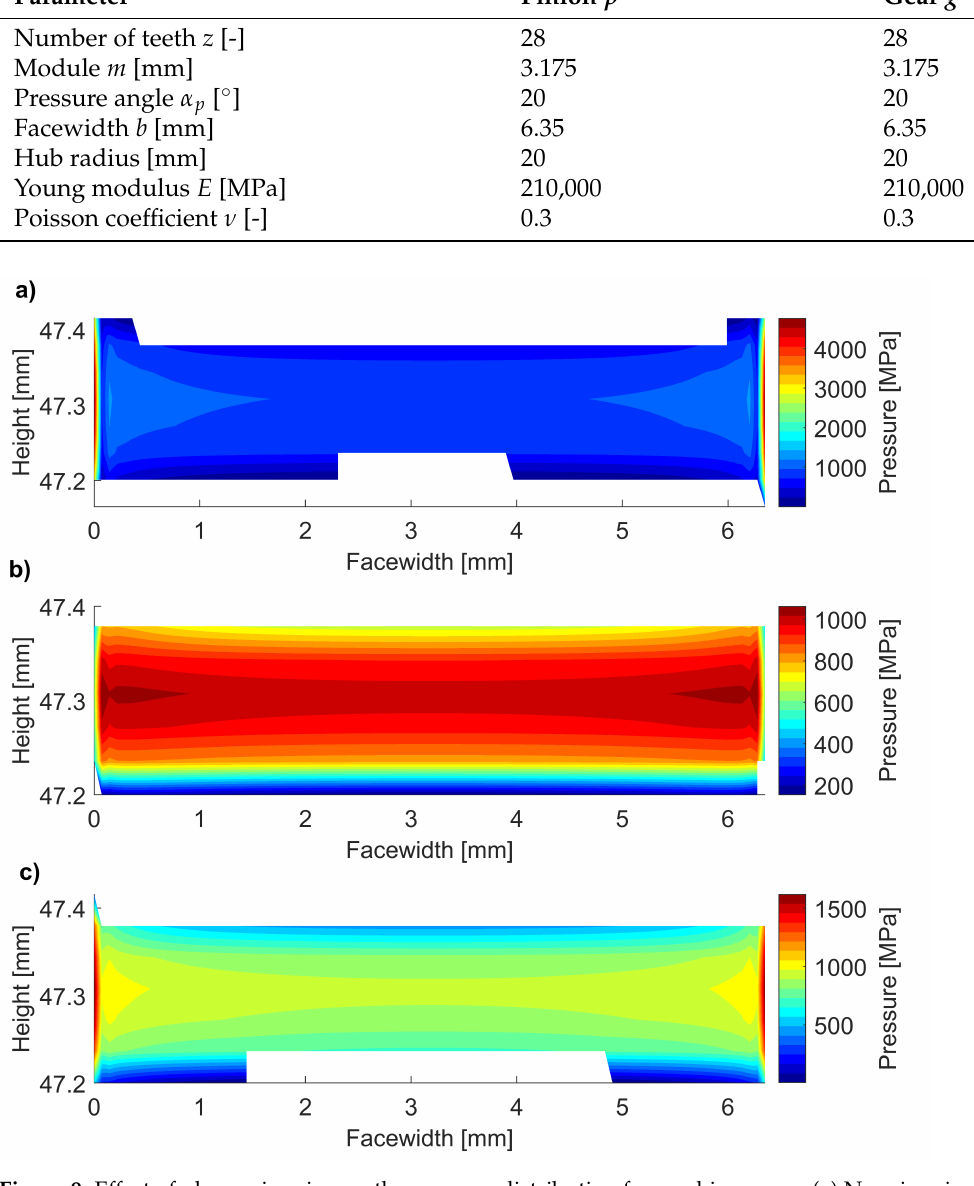
Figure 9. Effect of plane mirroring on the pressure distribution for meshing gears. ( a ) No mirroring, b p = b g ( b ) Mirroring, b p = b g ( c ) Mirroring, b p = 2 b g